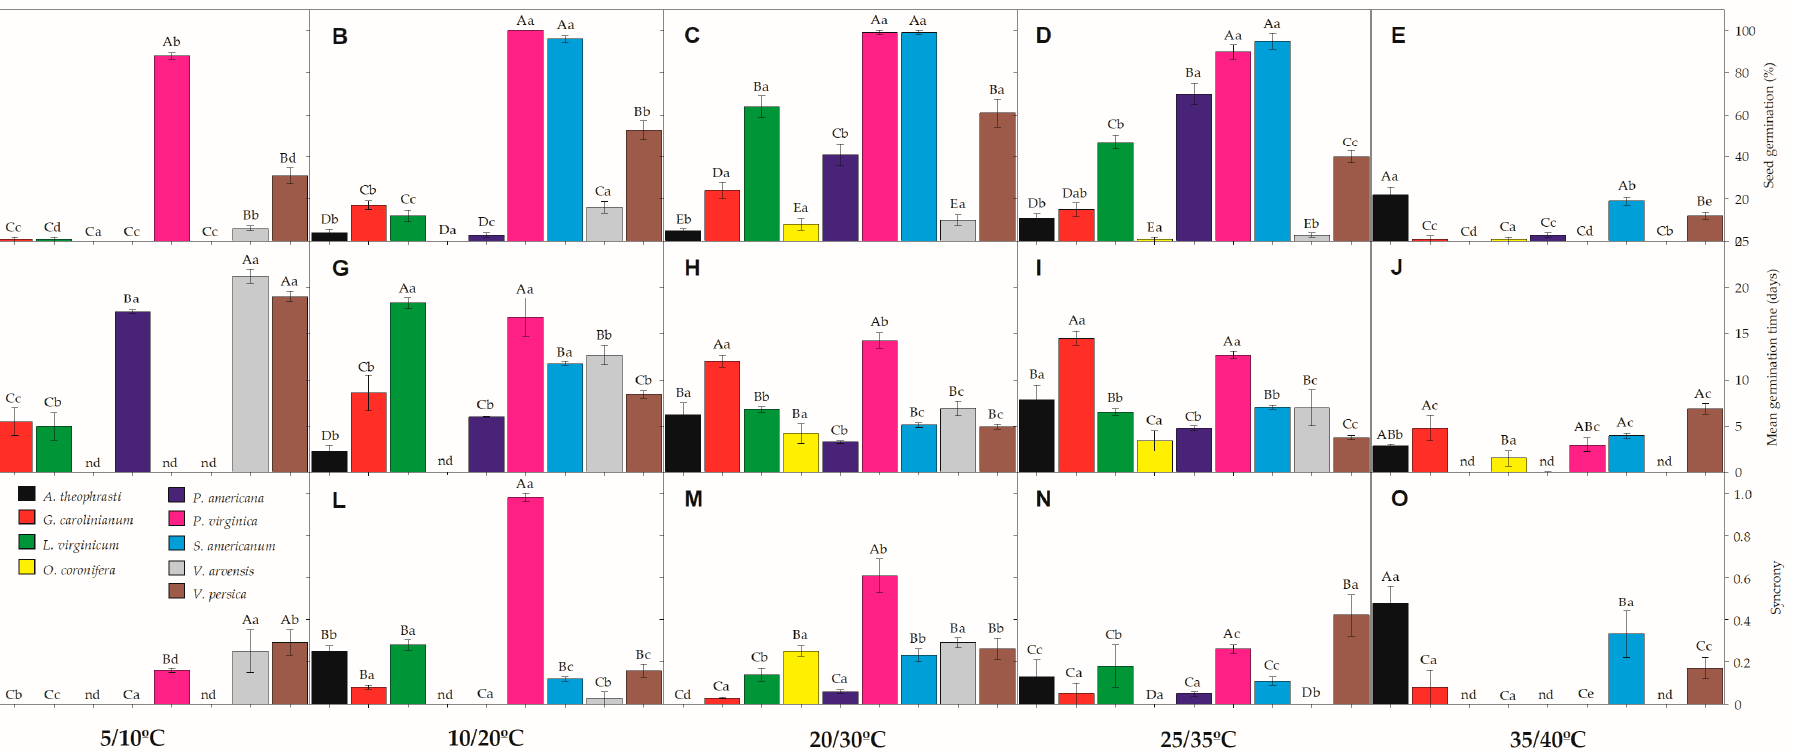
Figure 2. Germination ( A – E ), mean germination time ( F – J ), and synchrony ( K – O ) of the nine invasive species germinated in five different temperature regimes (5/10 °C; 10/20 °C; 20/30 °C, 25/35 °C, and 35/40 °C) in the light (12/12 h) photoperiod. Upper-case letters denote significant differences between species in each temperature incubation, and lower-case letters denote significant differences between temperature incubation within each species. nd denotes not determined due limit of the methodology. All values presented are the mean ± SE; α = 0.01. Color legend in K chart.